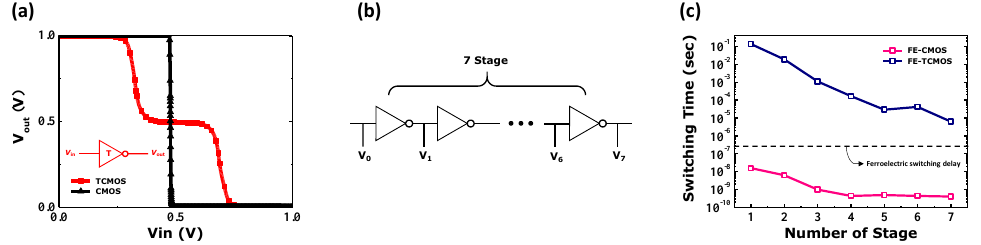
Figure 5. ( a ) The voltage transfer curves of conventional complementary metal-oxide-semiconductor (CMOS) and ternary complementary metal-oxide-semiconductor (TCMOS). The third V out state is formed in TCMOS by voltage dividing depending on I OFF di ff erence between TPMOS and TNMOS. ( b ) The circuit schematic diagram of 7-stage inverter chain. ( c ) The switching time of FE-CMOS and FE-TCMOS with respect to the number of inverter stages. The switching time of FE-CMOS is pico-sec order, whereas FE-TCMOS is micro-sec order. The dashed line represents ferroelectric switching delay, which is larger than the switching time of FE-CMOS.